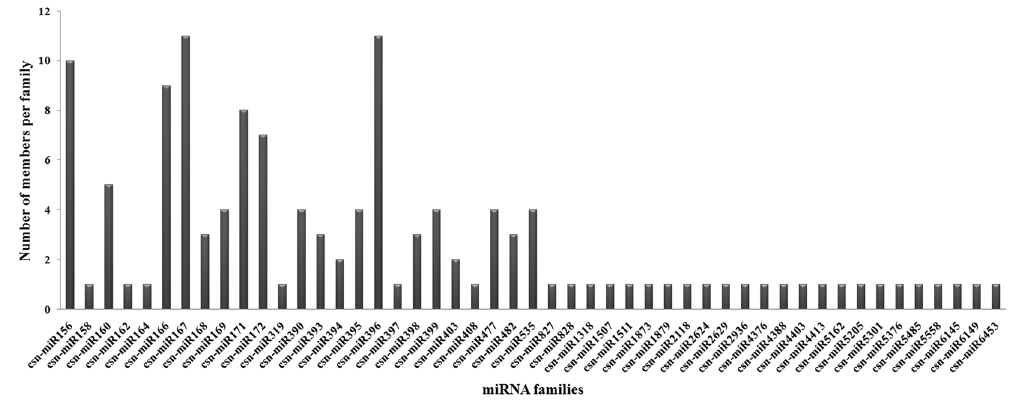
Figure 3. Number of conserved miRNA families in Camellia sinensis